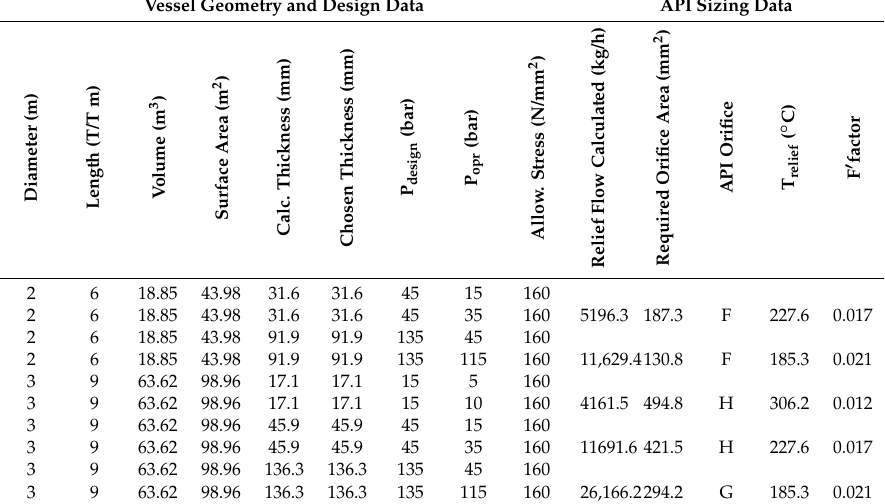
Table 3. Cont. Vessel Geometry and Design Data API Sizing